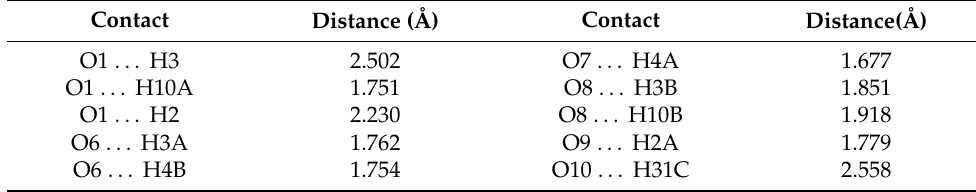
Figure 9. The fingerprint plots and d norm maps related to O ··· H contacts in 2 . The solid black arrows refer to the extra O10 . . . H31C interactions that exist in part 2 . Table 8. The short O ··· H contacts in complex 2